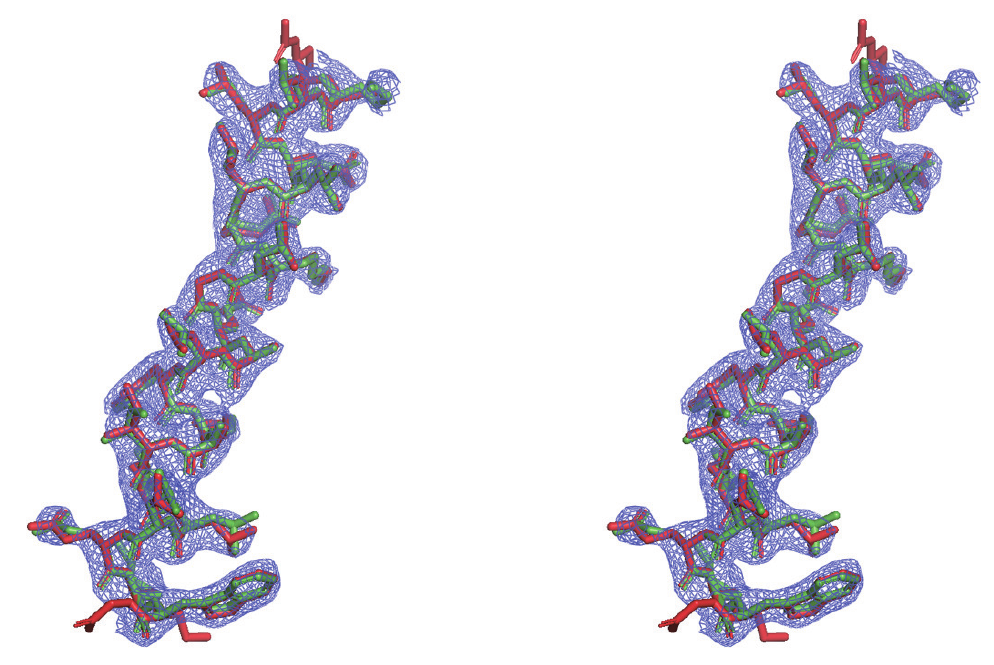
Figure 5. Stereograms of the calculated density map (blue mesh) of an α -helix of 6c4y, reconstructed model (green sticks) by ARP/wAPR [23] and PDB posted model (red sticks) [24].